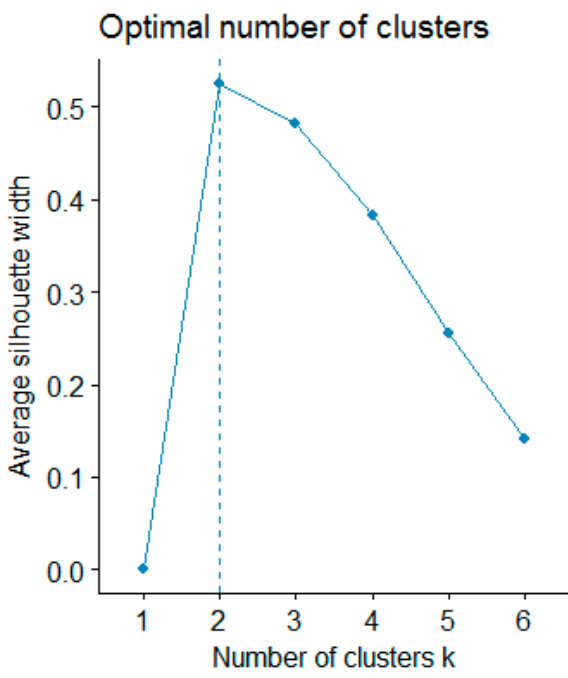
Figure 2. Value of average silhouette index for the different number of clusters.